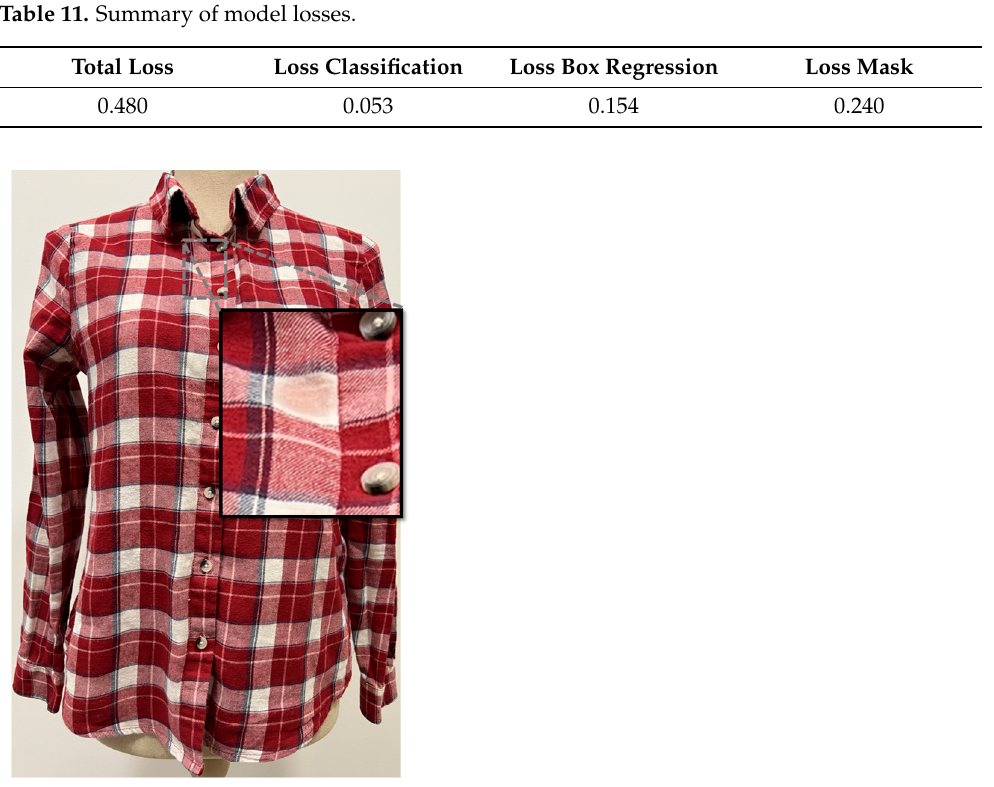
Figure 8. Example of a clothing item with